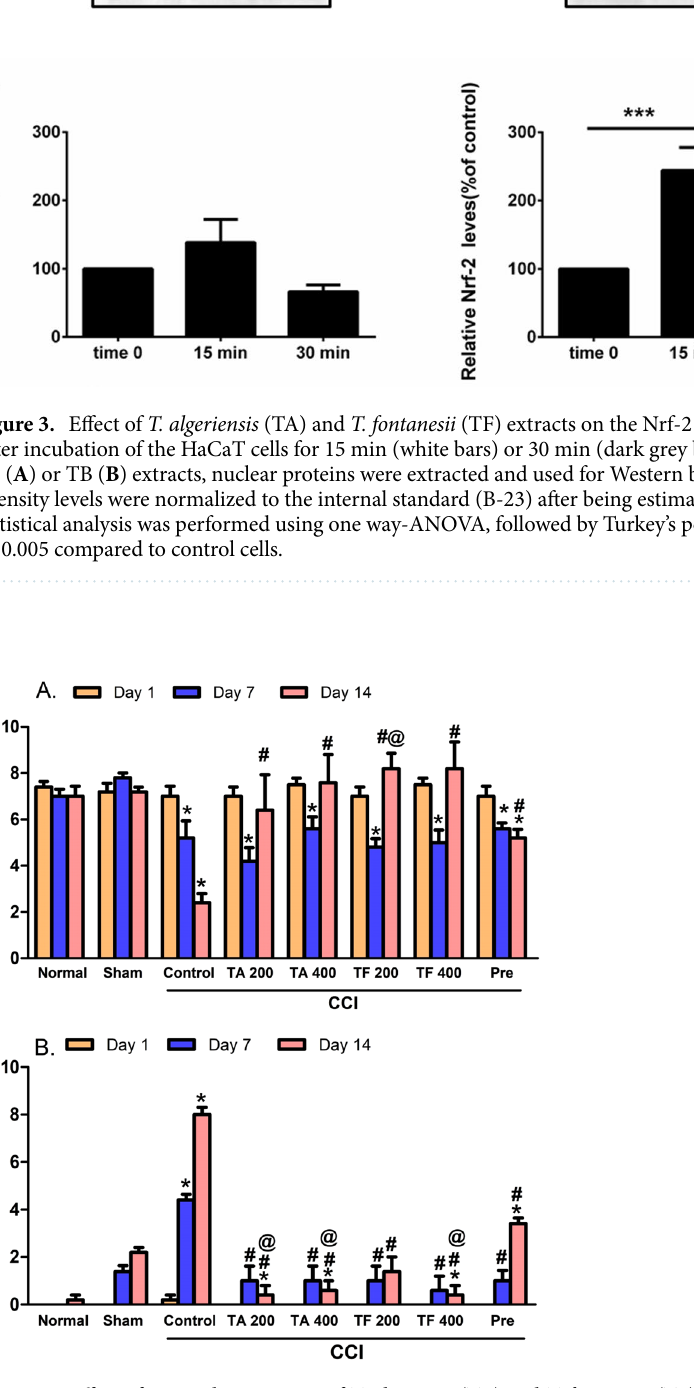
Figure 4. Effect of 200 and 400 mg/Kg of T. algerensis (TA) and T. fontanesii (TF) extracts against ( A ): heat hyperalgesia and ( B ): cold allodynia in neuropathic pain rats induced by spinal nerve ligation. Results are expressed as mean ± SE (n = 6). Statistical analysis was performed using RM-ANOVA, followed by Tukey post hoc test. The different symbols indicate the significance differences at p < 0.05 when compared with sham group (*), CCI group (#), and pregabalin group (Pre, @ ) at the different time points as indicated in the materials and methods